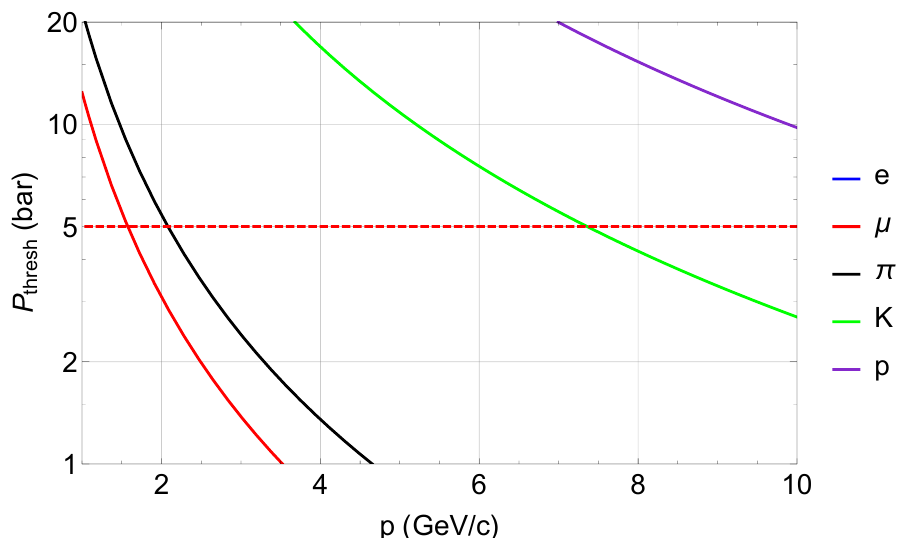
Figure 8. Threshold pressures of a threshold Cherenkov counter typically used in the CERN experi- mental areas. For energies above 4 GeV/c and using two counters, one at 5 bar and another e.g., at 2 bar, protons can be separated by pions. Above 6 GeV/c kaons can be tagged, too. Electrons are always ultra-relativistic and can be identified at any momentum.